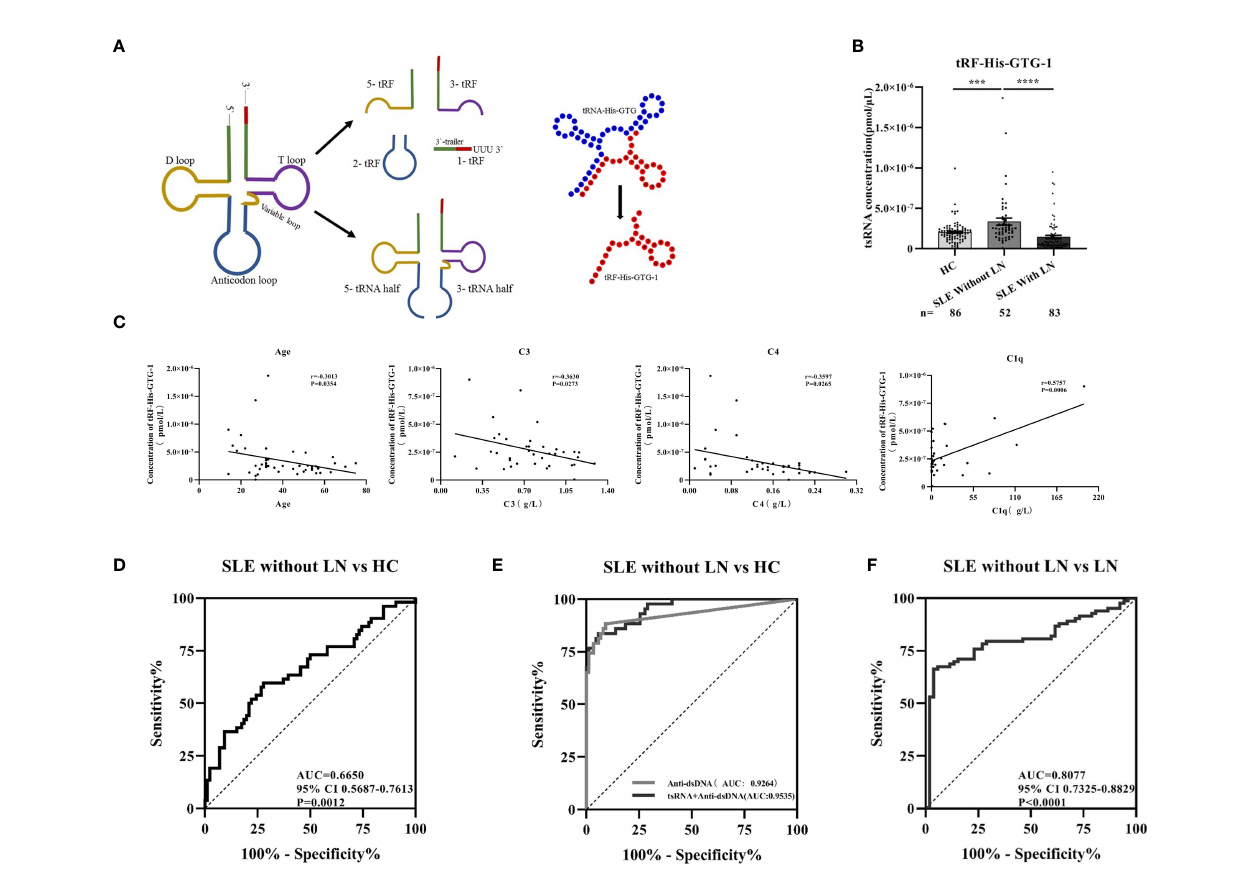
FIGURE 4 | Diagnostic use of serum tRF-His-GTG-1 in systemic lupus erythematosus (SLE). (A) Schematic diagram of tRF-His-GTG-1 biogenesis and secondary structure. (B) RT-qPCR veri fi cation of tRF-His-GTG-1 in SLE without lupus nephritis (LN), SLE with LN, and normal. Statistical signi fi cance was determined by one- way ANOVA (***P < 0.001, ****P < 0.0001). (C) Analysis of the correlation between tRF-His-GTG-1 and age, C3, C4, and C1q. Statistical correlation was determined by linear regression and Pearson correlation. (D) Receiver operating characteristic (ROC) curve analysis of tRF-His-GTG-1 in SLE without LN and healthy controls. (E) ROC curve combined diagnostic analysis of tRF-His-GTG-1 and anti-dsDNA in SLE without LN and healthy controls. SPSS binary logistic regression was used to predict the probability of joint diagnosis. (F) ROC curve analysis of tRF-His-GTG-1 in SLE without LN group and SLE with LN